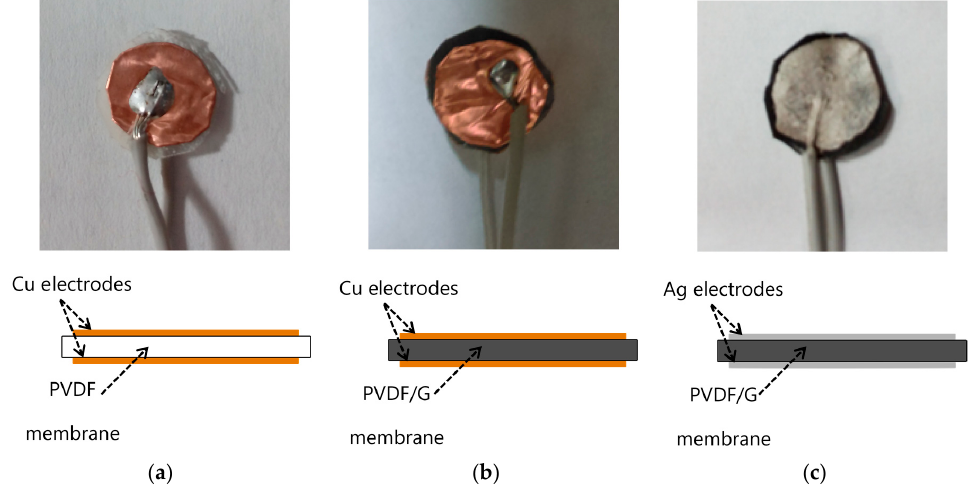
Figure 3. ( a ) PVDF-Cu; ( b ) PVDF/G-Cu and ( c ) PVDF/G-Ag samples.